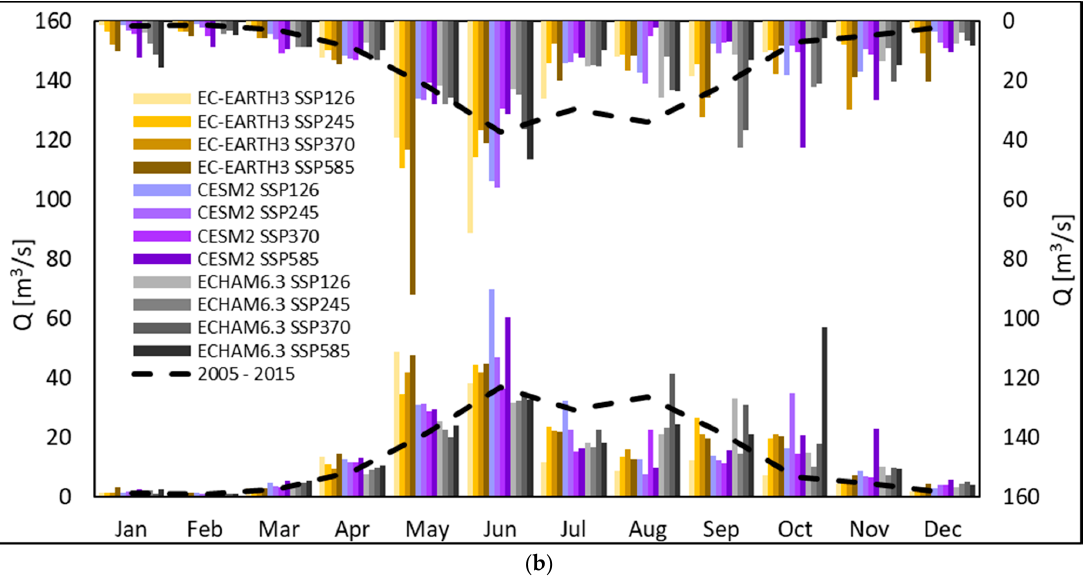
Figure 3. Mean projected monthly incoming discharge Q (m 3 s − 1 ) at the Chavonne plant. In the left y axis, we reported the monthly incoming discharge during the period P1, 2040 − 2049. In the right y axis, i.e., with the uppermost bars, with values to be read upside-down, we reported the monthly incoming discharge during the period P2, 2090–2099. We also report control run (2005–2015, black dashed line). ( a ) GCMs: Ec-Earth, CCSM4, ECHAM6.0. Scenarios: RCP 2.6, RCP 4.5, RCP 8.5. ( b ) GCMs: Ec-Earth3, CESM2, ECHAM6.3. Scenarios: SSP1 2.6, SSP2 4.5, SSP3 7.0, SSP5 8.5.